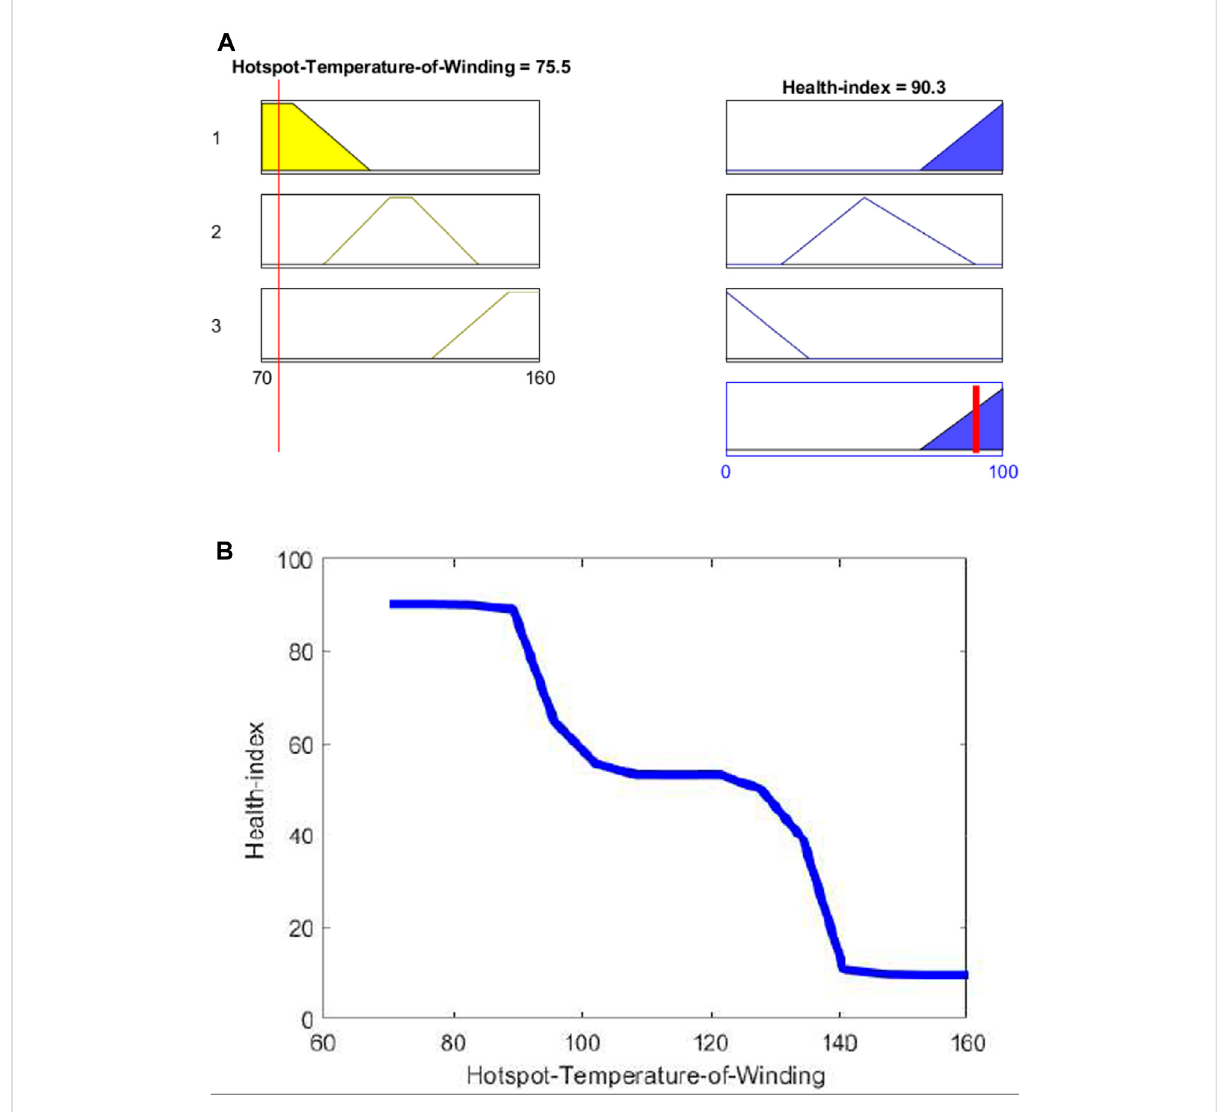
FIGURE 9 (A) Rules used in fuzzy sublogic for the hot spot temperature of winding. (B) Plot formed for the hot spot temperature of